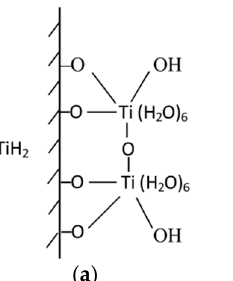
Figure 10. Screening of the titanium hydride ( a ) shot surface and formation of hydroxotitanyl ( b ) on the surface.